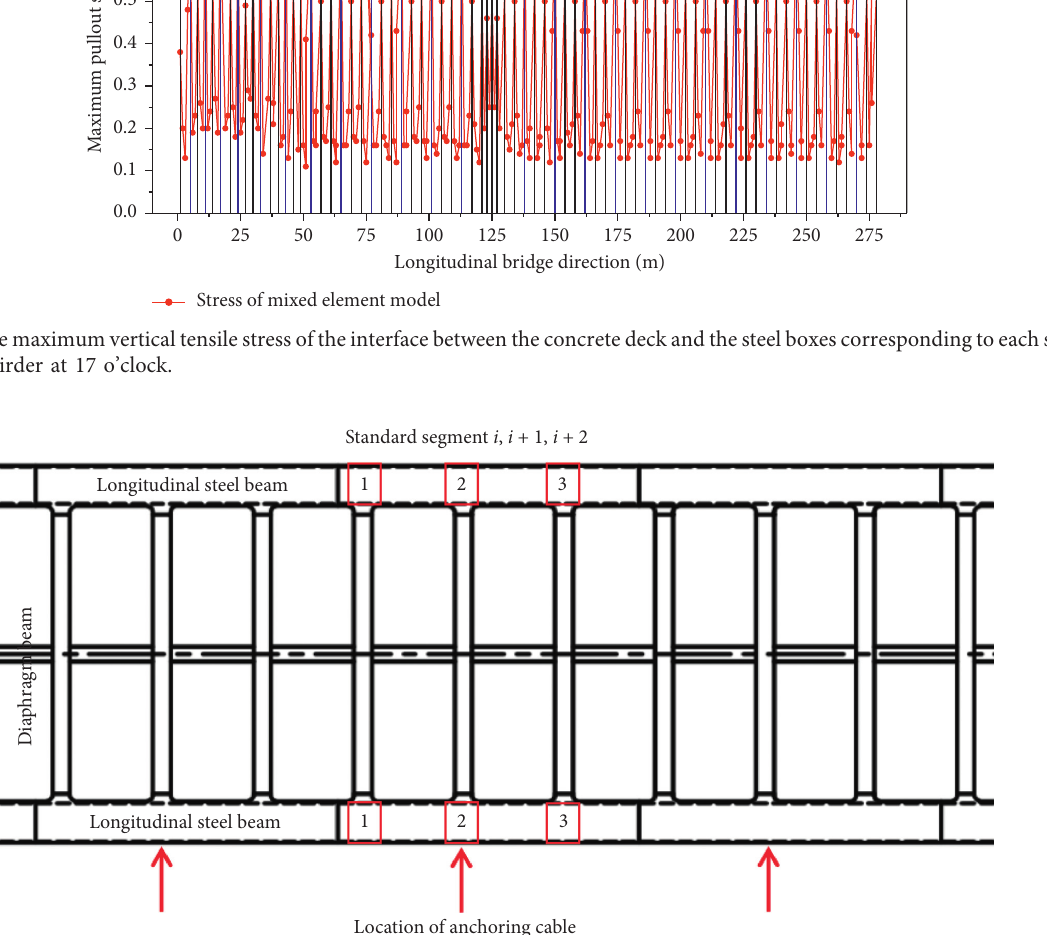
Figure 25: Diagram of the maximum interfacial stress